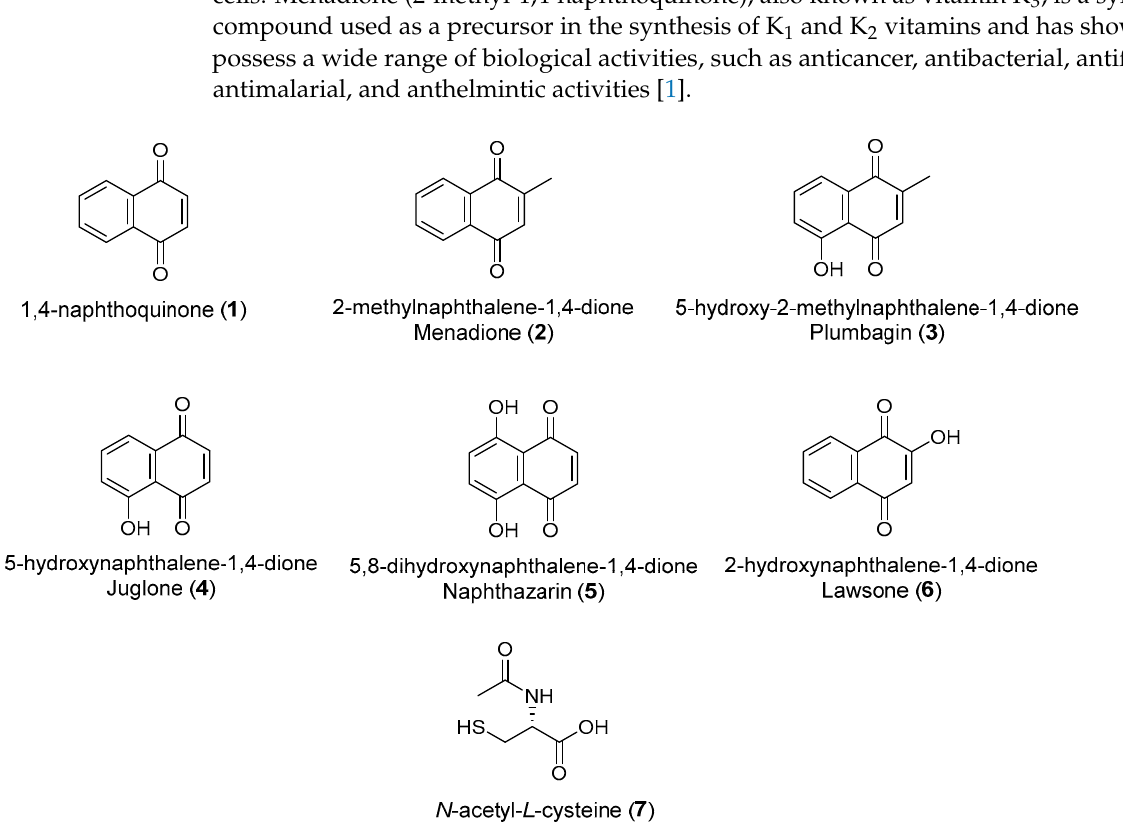
Figure 2. Naphthoquinones 1 – 6 reacted with N -acetyl- L -cysteine ( 7 ) in the current